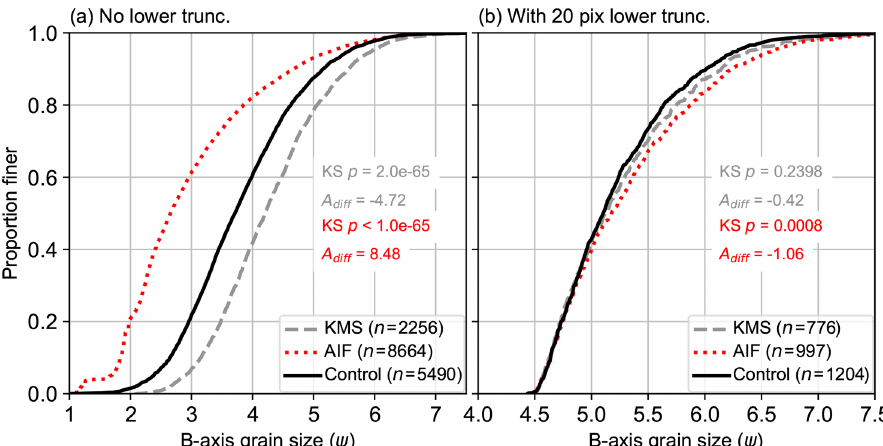
Figure 11. Results from hand-clicked control (black line), KMS PebbleCounts (gray, dashed line), and AIF PebbleCountsAuto (red, dotted line) with the initial non-truncated run (a) and the 20-pixel truncated run (b) . In corresponding colors are the p value results of a KS test and the A diff approximate integral between the curves for each approach versus the control data. The legend indicates the number of grains ( n ) making up each curve. Note the reduction in x -axis scale between the columns, where the right truncated distributions are plotted on a narrower range to emphasize the remaining discrepancies. The curves separated by site (Fig. 6b) are shown in Sect. S5 and Fig.